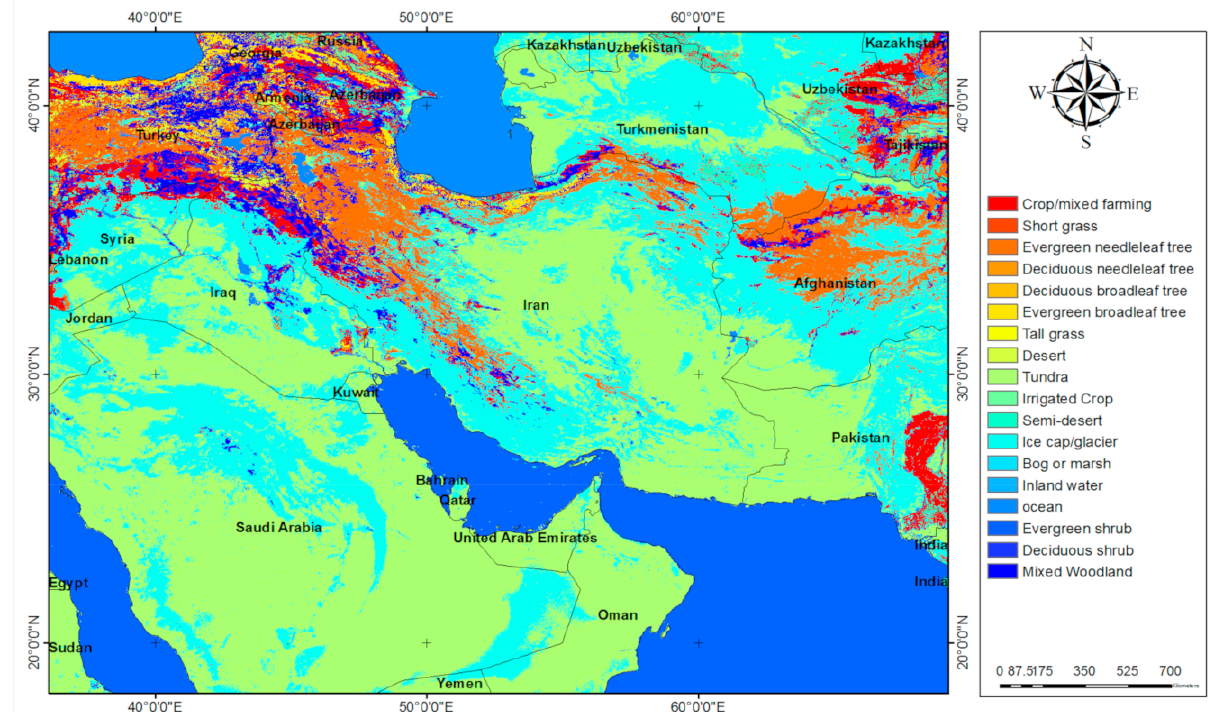
Figure 7. Land cover map used by RegCM4 model over the study